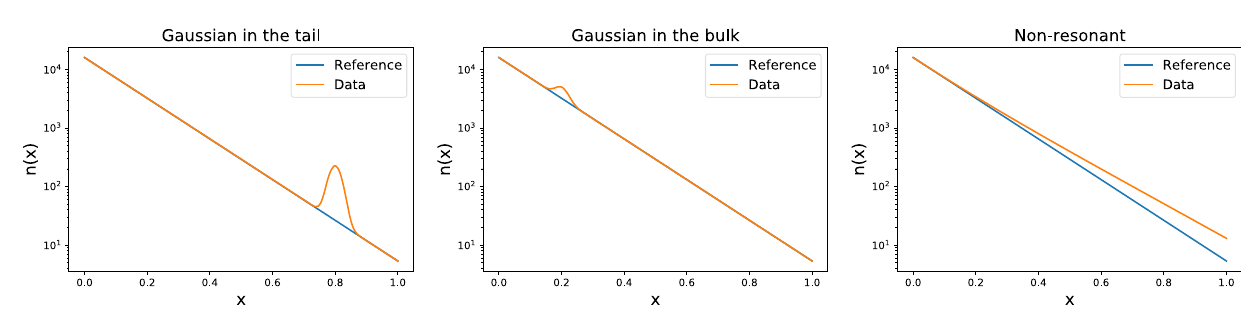
Fig. 8 True univariate